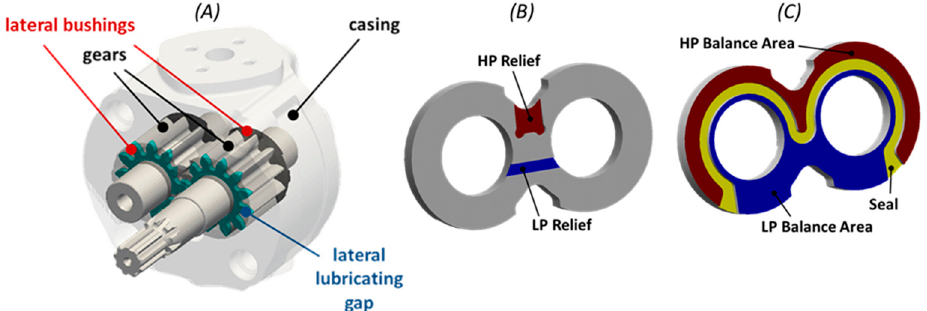
Figure 1. ( A ) Illustration of lubricating interfaces between the lateral bushings and gears in EGMs. Common designs of lateral bushings include pressure plates as represented in this figure and a bearing block design which also includes structural support to the shaft; ( B ) Relief grooves are highlighted in the side of the lateral bushing facing the gears; ( C ) Representation of HP and LP balance areas separated by a seal on the side of the lateral bushing facing away from the gears.